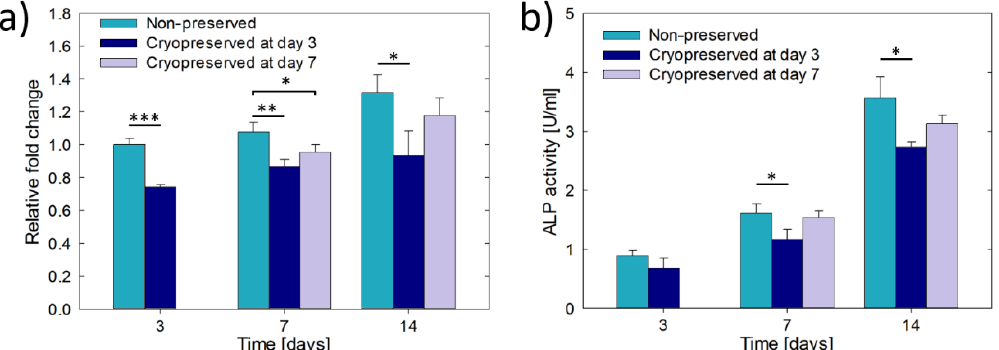
Figure 6. Results of cryopreservation of Saos-2 cells encapsulated in hydrogel and infiltrated in -TCP scaffolds: ( a ) cell metabolic activity expressed as relative fold change compared to the cell metabolic activity obtained at day 3 without cryopreservation, and ( b ) ALP activity. Asterisks indicate statistically significant differences at * p < 0.05, ** p < 0.01, *** p < 0.001, n = 3.